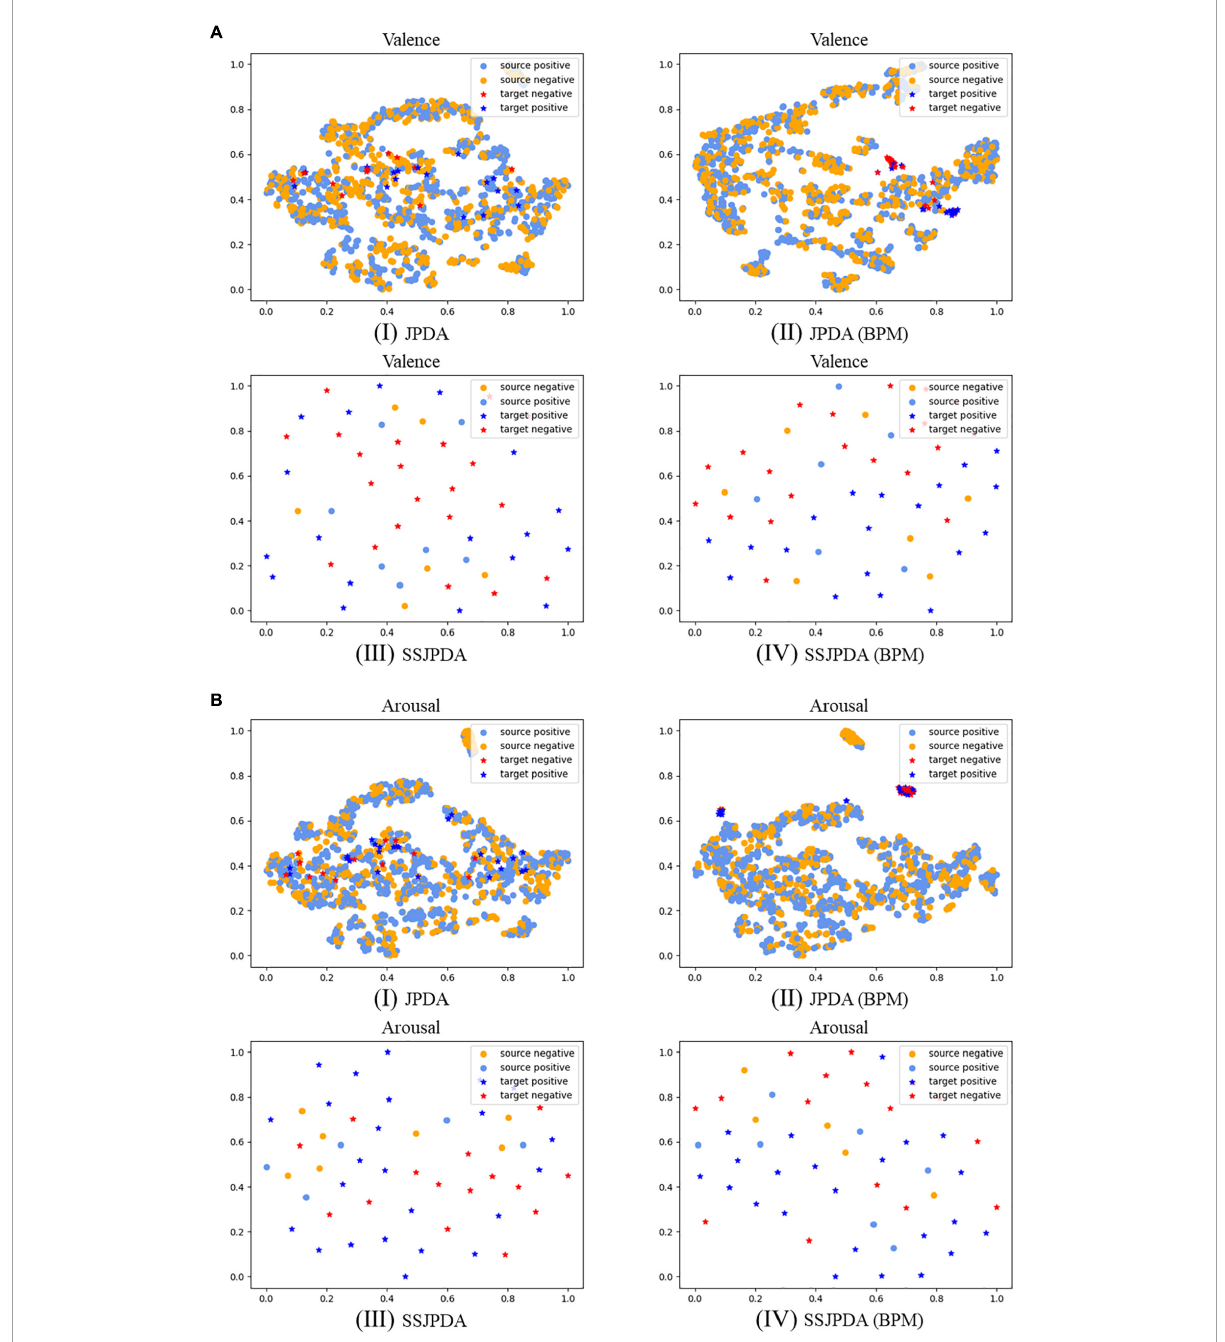
FIGURE1 The source and target domain’s prediction samples are projected to two-dimensional visualization through t-SNE in multimodal data experiments with different algorithms. (A) Shows valence classification representations, and (B) shows arousal classification representations, where (I) is JPDA algorithm, (II) is JPDA (BPM) algorithm, (III) is SSJPDA algorithm, (IV) is SSJPDA(BPM)